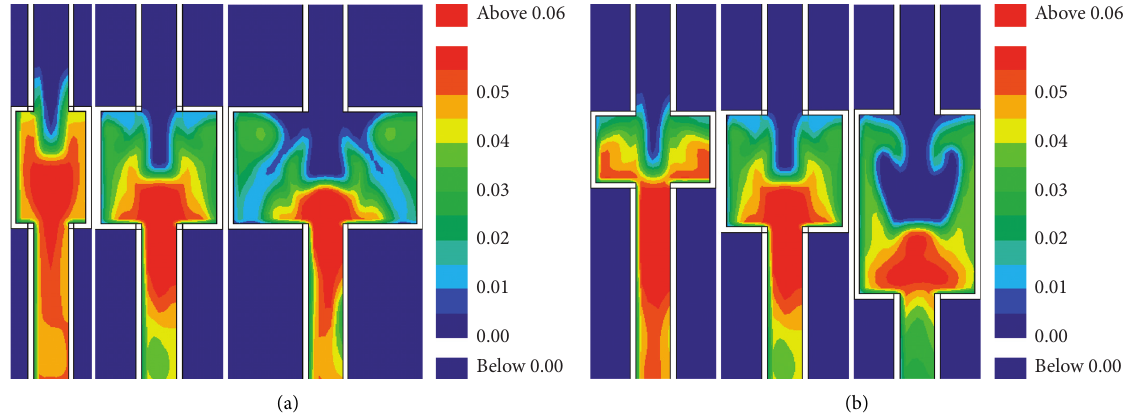
Figure 8: Propagation of premixed methane in chambers with different geometric parameters. (a) Variable-width chambers (0.2m high and 0.5m long); (b) variable-length chambers (0.2m high and 0.5 m